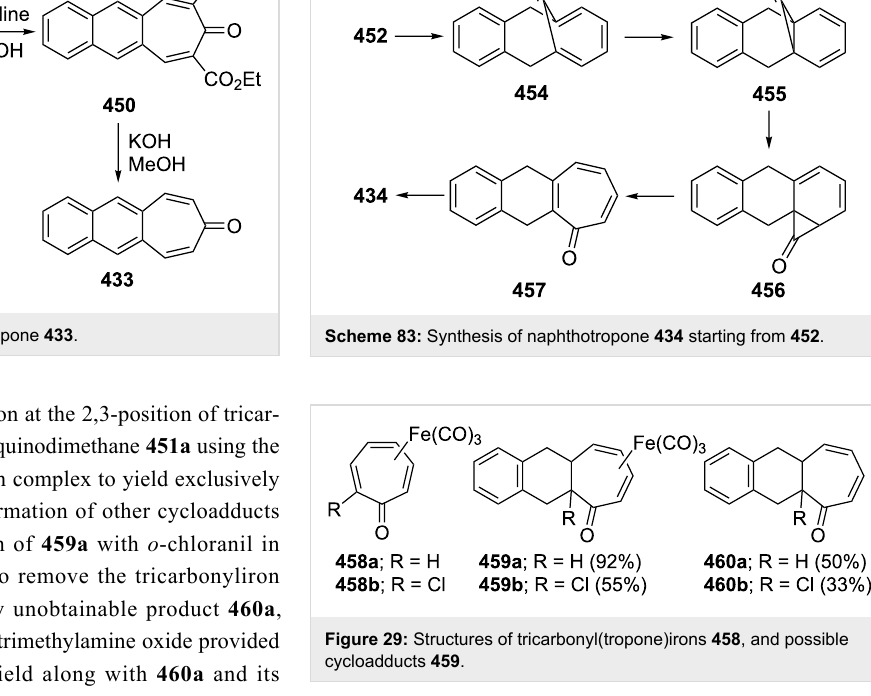
generation of 13 from the corresponding benzocyclobutene 230 , Ohkita’s group also reported the synthesis of 465 as a precursor for naphthotropone 435 (Scheme 85) [220,221]. Photo- promoted [2 + 2] cycloaddition of 2-cyclopentenone with ( E